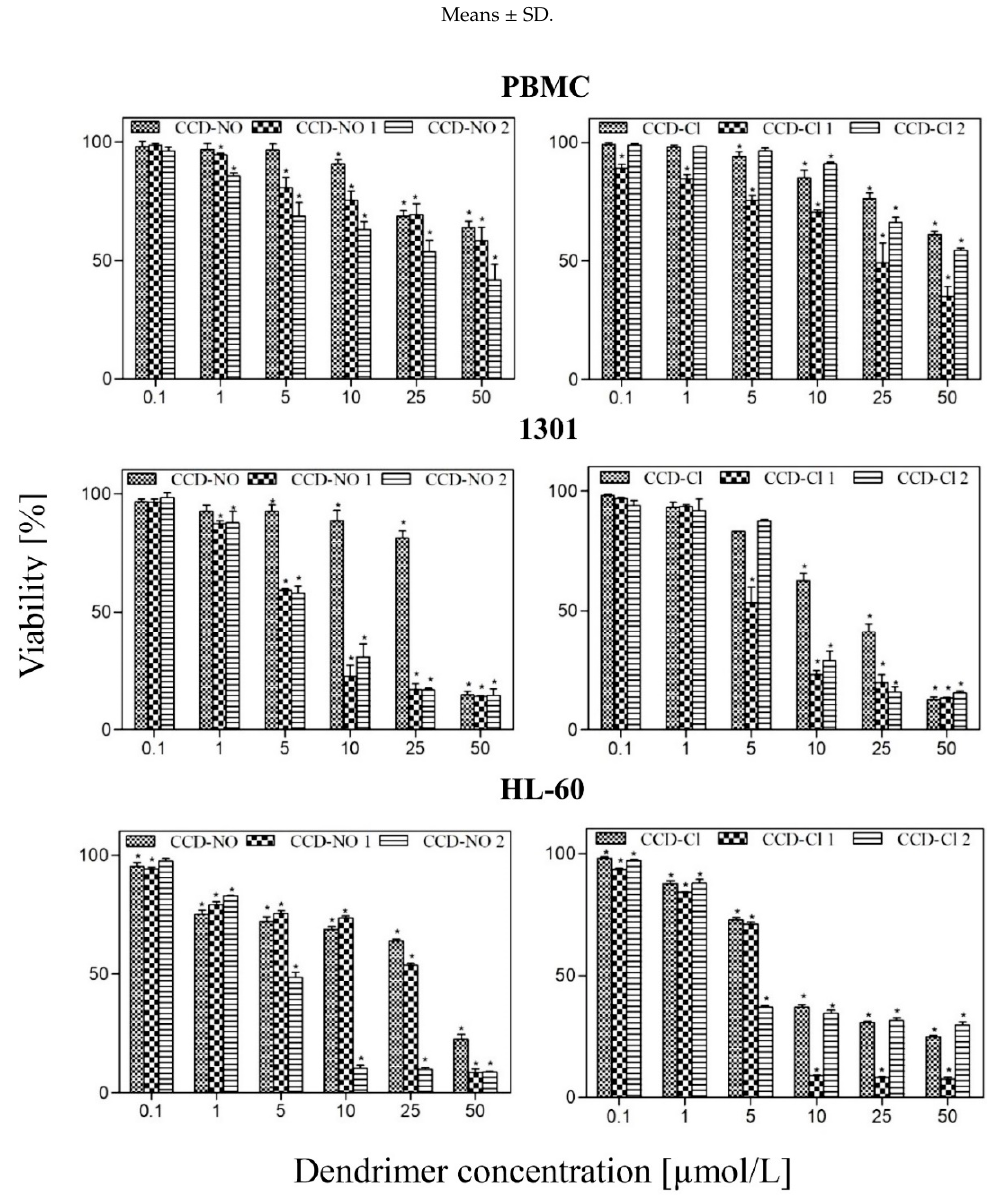
Figure 7. Effect of copper metallodendrimers on the viability of normal PBMC and cancer: 1301, HL-60 cell lines after 24 h incubation. The concentration range was 0.1–50 µmol/L. The values are the mean ± SD of n ≥ 6.